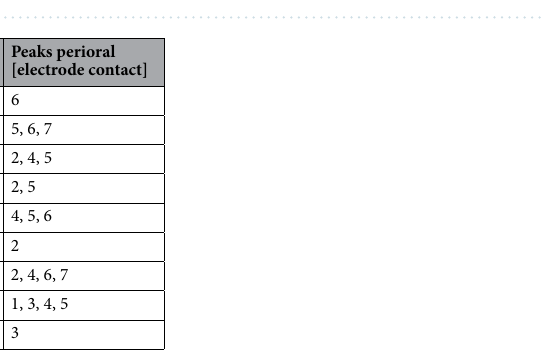
Table 5. Listing of electrode contacts per subject with the shortest electrode facial nerve distance (EFND) and EMG peaks in the periocular and perioral EMG channels, which exceeded the threshold at 75% normalized EMG